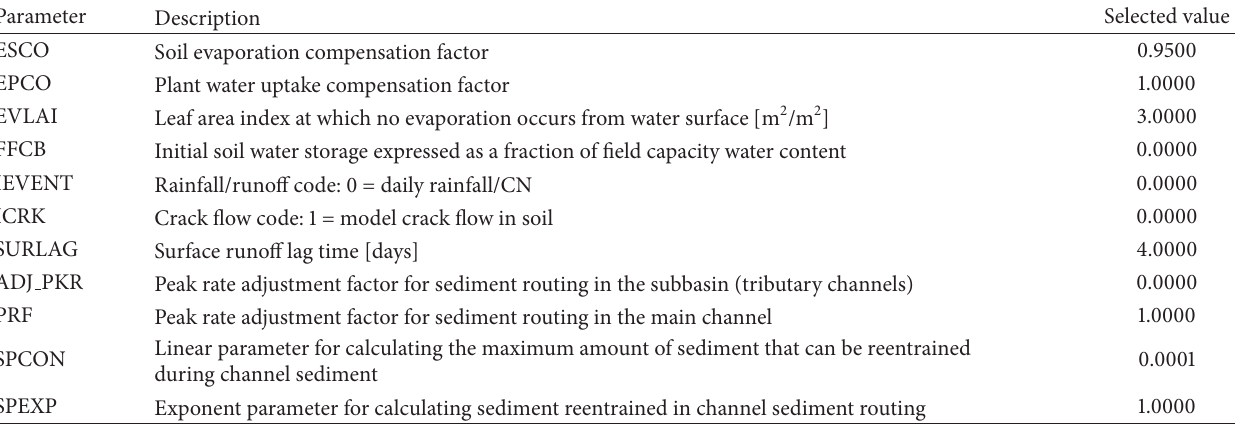
Figure 3: Calibrated model result using original precipitation input. 𝑥 -axis represents time in days and 𝑦 -axis represents flow in cubic meters per second. Table 4: Details of SWAT parameters which are related to runoff mechanism for Imha